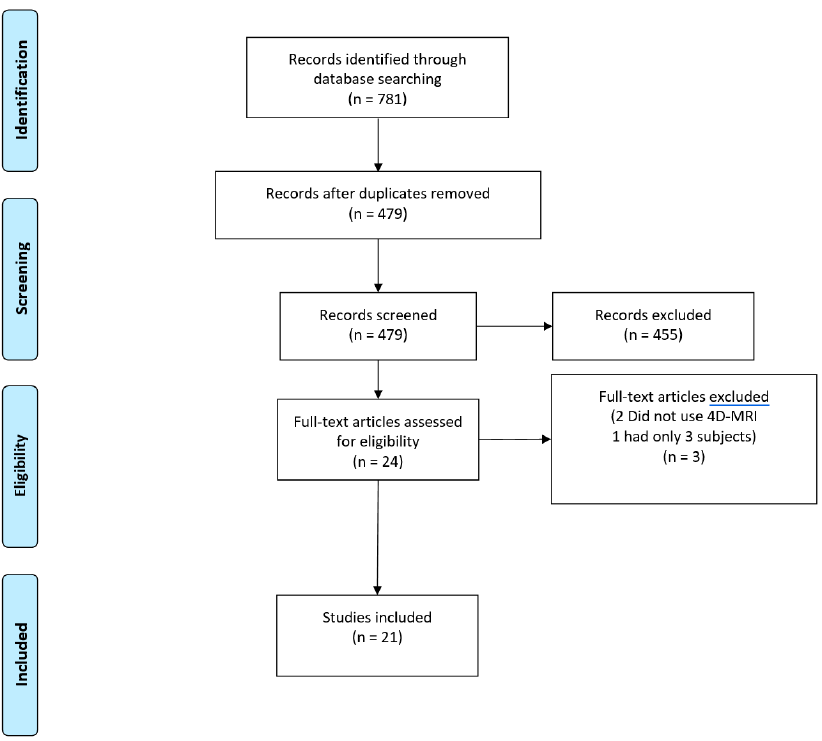
Figure 1. PRISMA flowchart of the inclusion process.